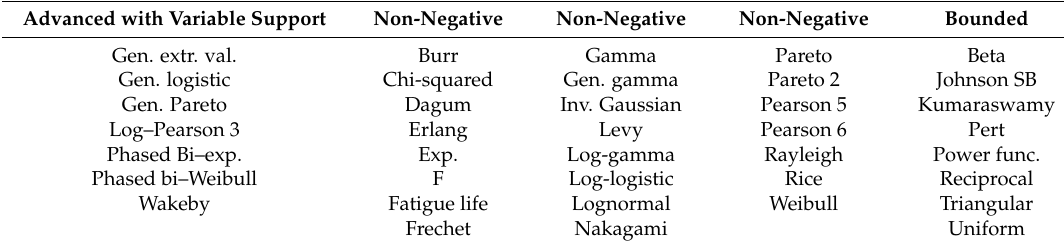
Table 2. Fitted distribution functions (total of 38 types).